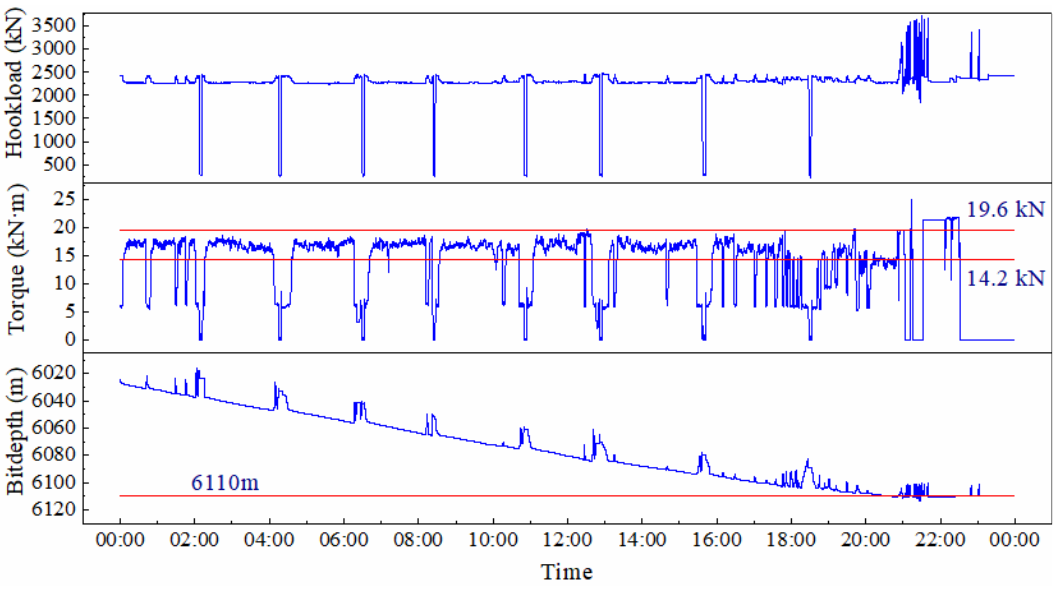
Figure 5. Hook tension and torque changes in the whole day on 2 May.